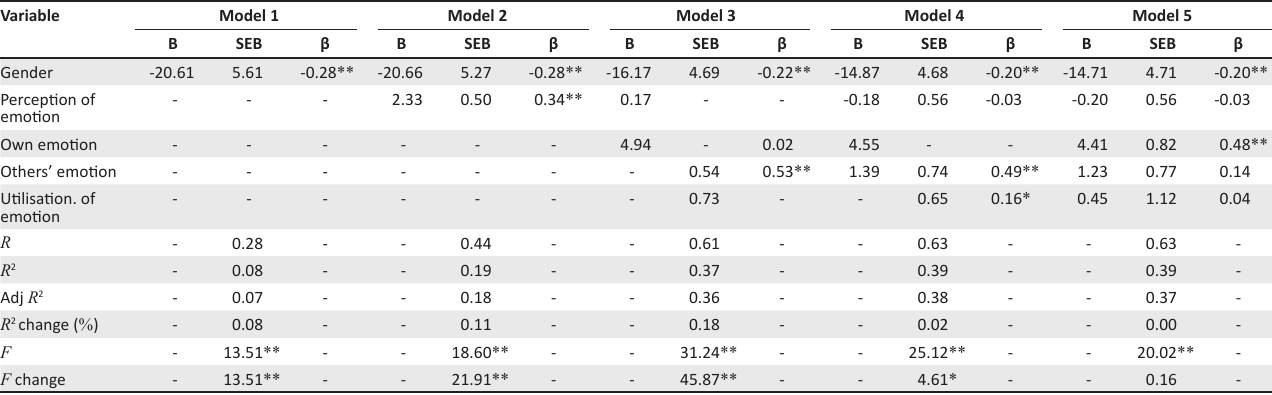
TABLE 2: Five-model hierarchical multiple regression analysis of gender and emotional intelligence dimensions predicting career adaptability ( N = 160).